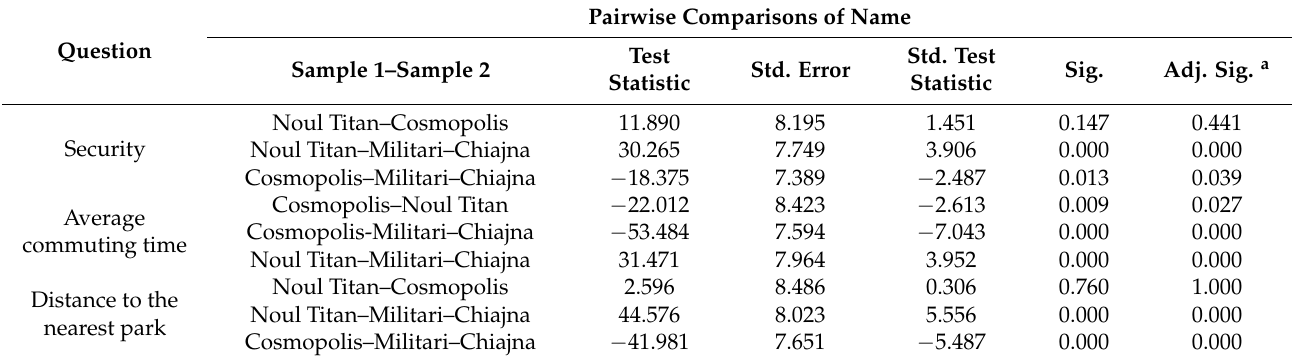
Table 4. Post hoc analysis results of pairwise Dunn’s tests for the questions’ items with Likert scale responses, which yielded significant Kruskal–Wallis test